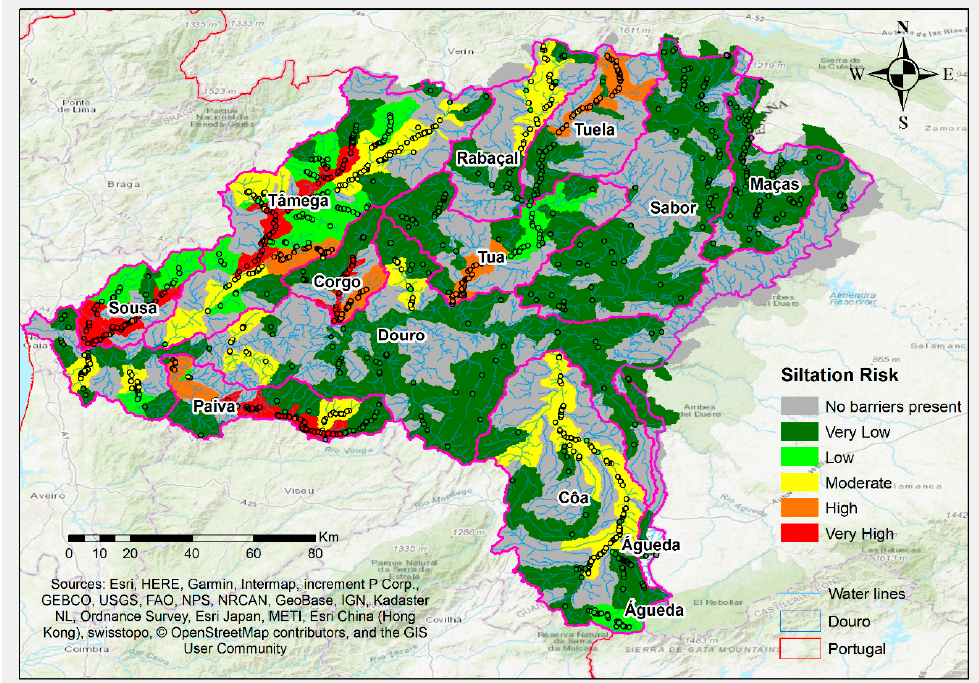
Figure 5. Map of the siltation risk along the main tributaries of the Douro river basin.